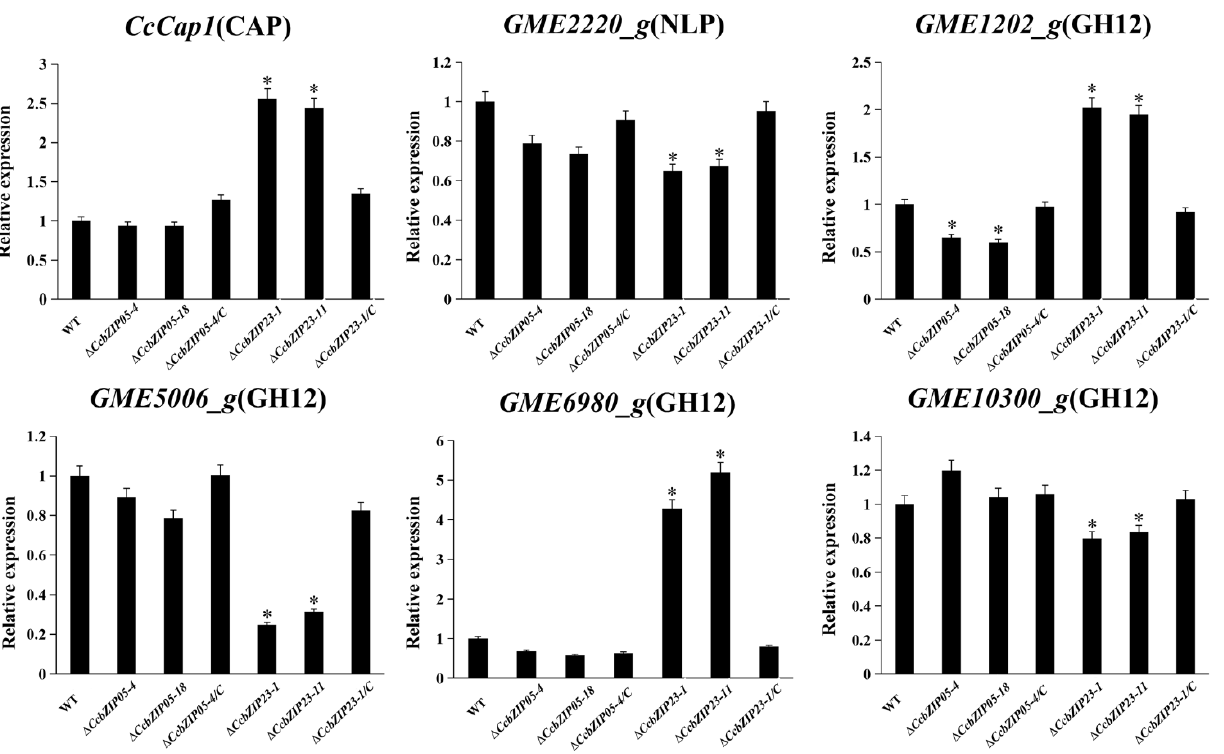
Figure 10. CcbZIP05 and CcbZIP23 differentially regulate expression of putative effector genes. The qRT-PCR was used to measure the expression levels of putative effector genes in the wild-type, Δ CcbZIP05 and Δ CcbZIP23 mutants, and complemented strains. The CcActin gene was used as the reference gene. The experiments were repeated three times. The data were analyzed using one-way ANOVA and Duncan’s range test. The asterisks indicate significant differences ( p < 0.05).